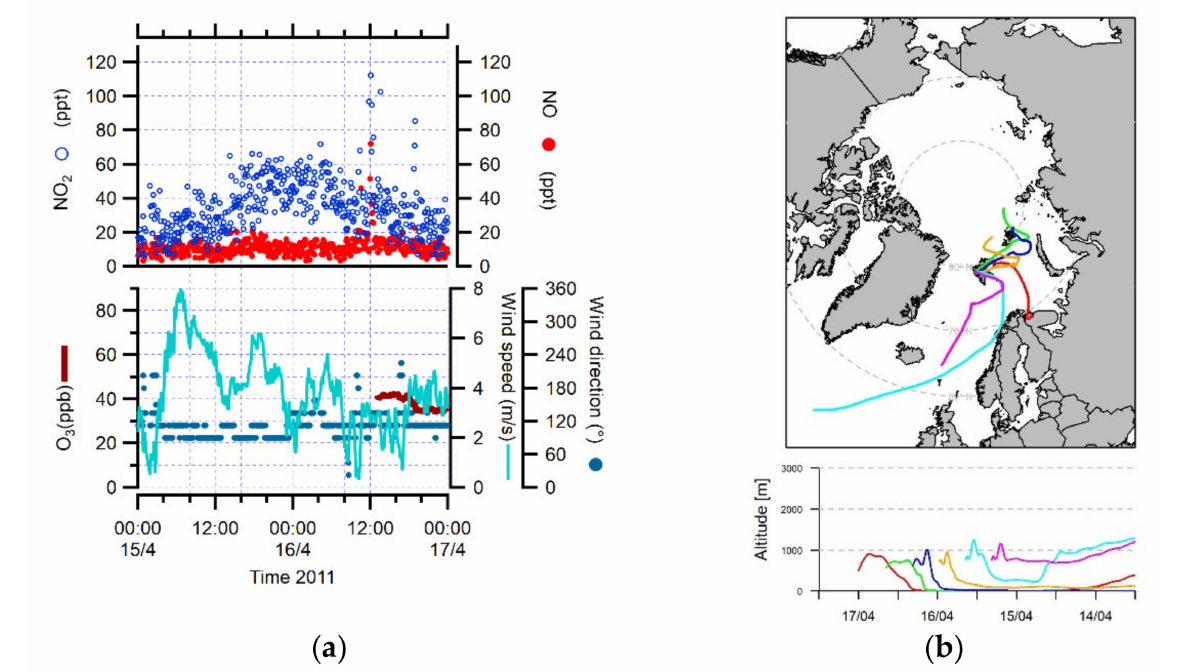
Figure 3. ( a ) NO, NO 2 , O 3 concentrations, wind speed and direction during the transport event from Europe (15–16 April 2011). ( b ) 5-day back trajectories for 17 April 2011 at 00:00 UTC, calculated every 12 h above